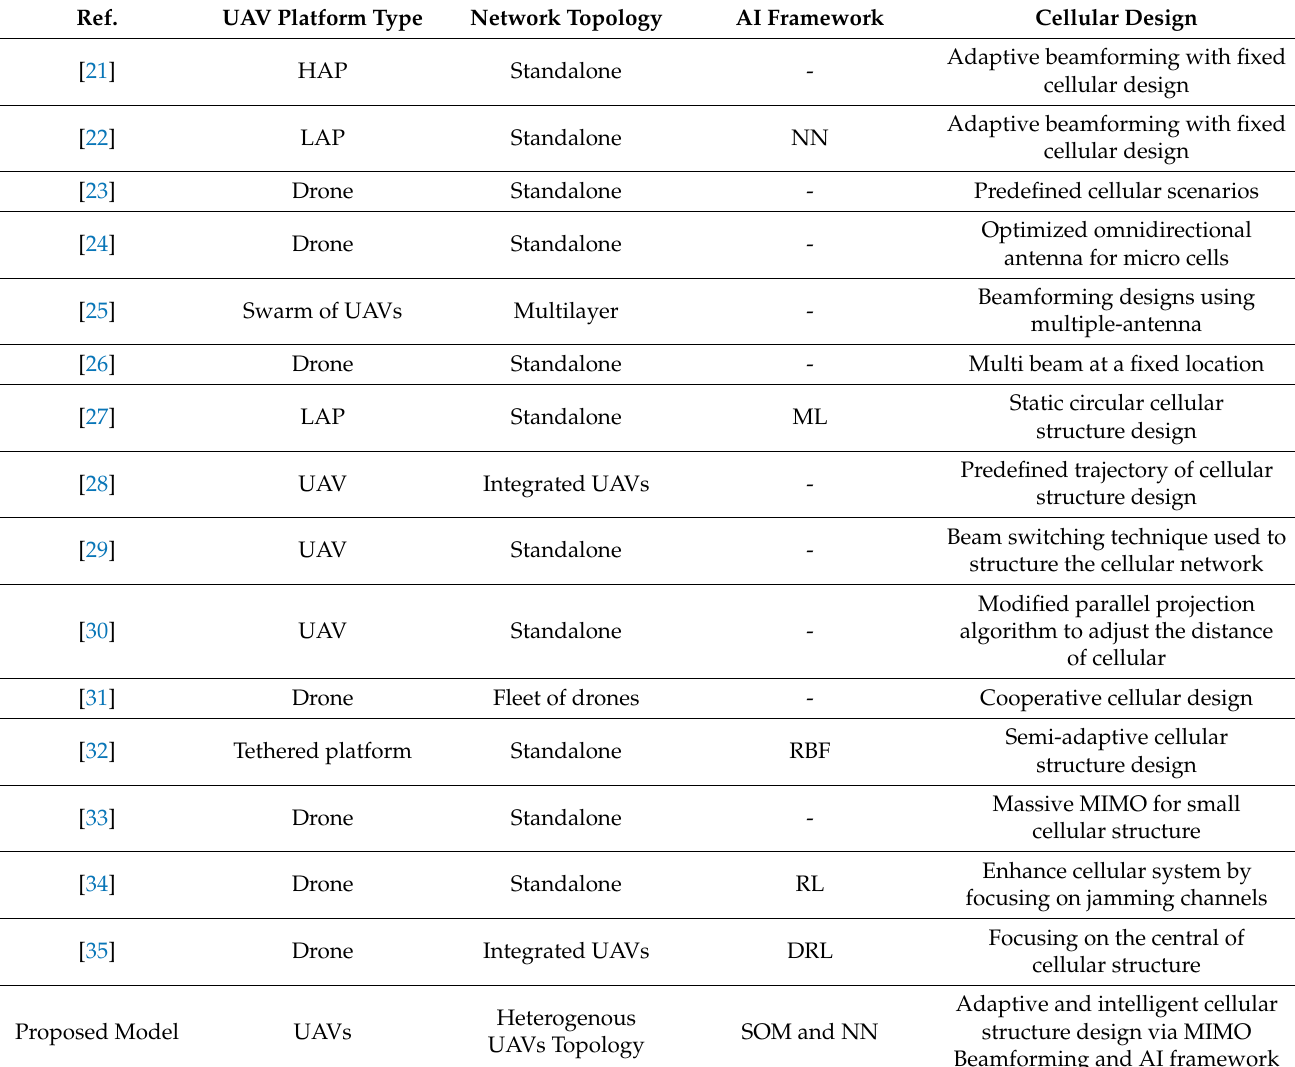
Table 1. Comparison between related studies against the proposed model.